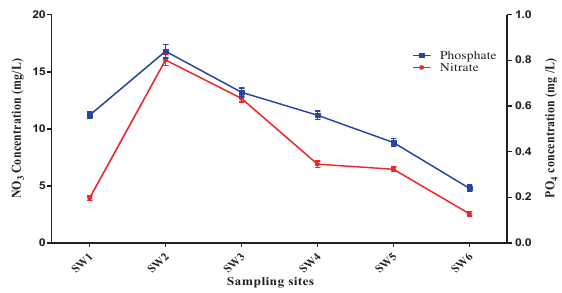
Figure 4 Figure 4: Nitrate and phosphate concentrations of surface water and leachate